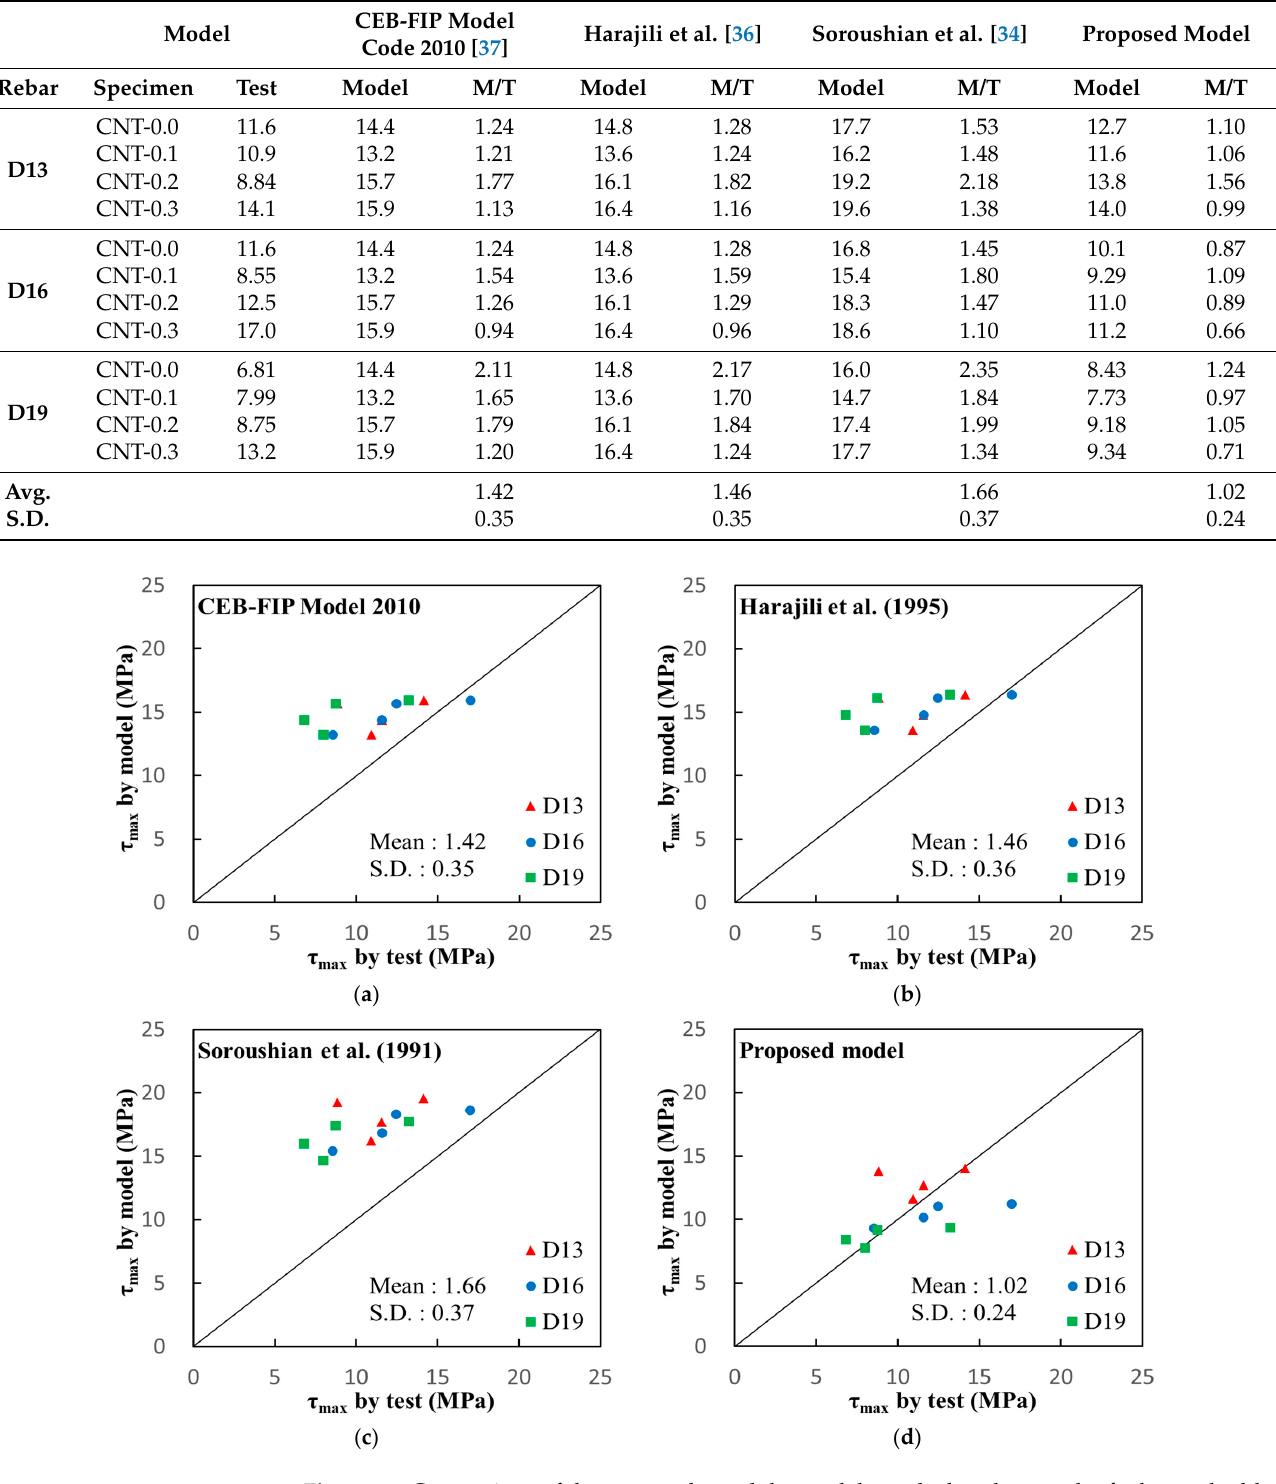
Table 8. Comparison on the bond strength between the test results and the models.